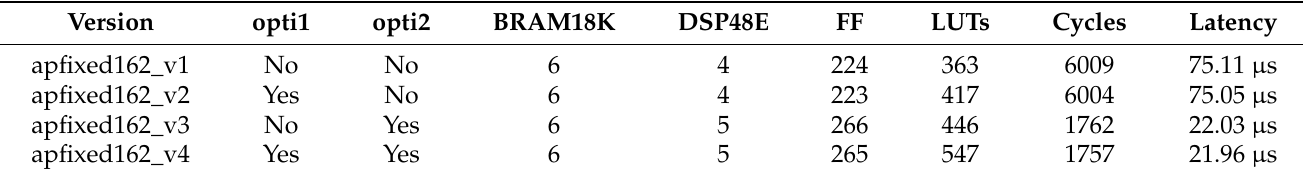
Table 1. Implementations